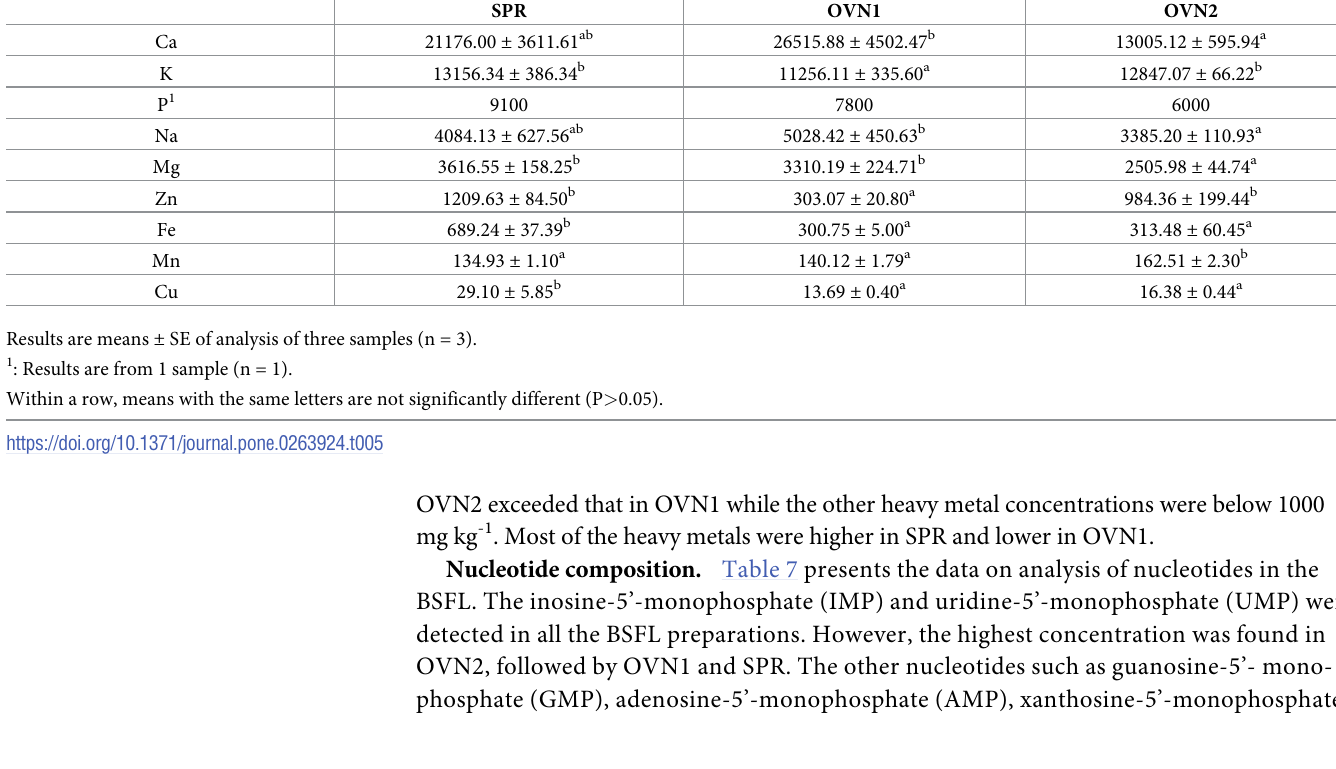
Table 5. Mineral composition of three different types of BSFL. Minerals (mg kg -1 )